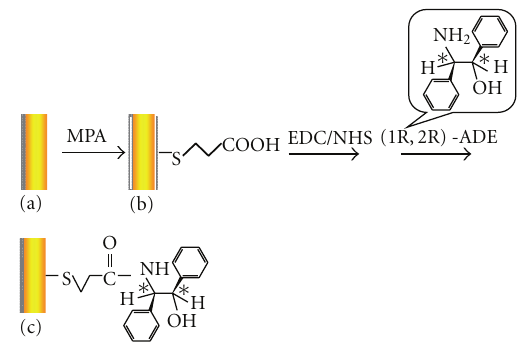
Figure 1: Schematic illustration of the modified electrode: (a) Bare Au electrode; (b) MPA self-assembled Au electrode; (c) (1R, 2R)- ADE-MPA modified Au